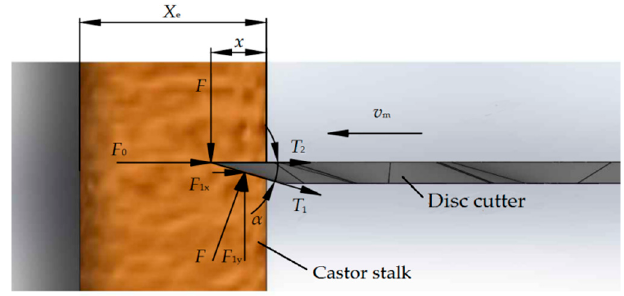
Figure 4. Cutting force of the stalk.